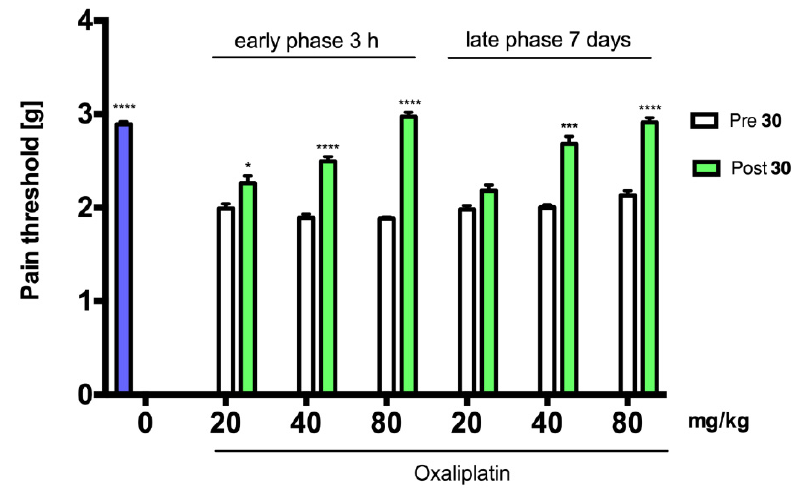
Figure 4. Antiallodynic e ff ects of compound 30 administered at the doses of 20 mg / kg, 40 mg / kg, and 80 mg / kg in the tactile allodynia evaluated in the von Frey test in the oxaliplatin (OXPT)-induced model of peripheral neuropathy. Results compared to vehicle-treated group (pre 30 ). Statistical analysis: repeated measures analysis of variance (ANOVA), followed by Dunnett’s post hoc comparison: * p < 0.05, *** p < 0.001, **** p < 0.0001.